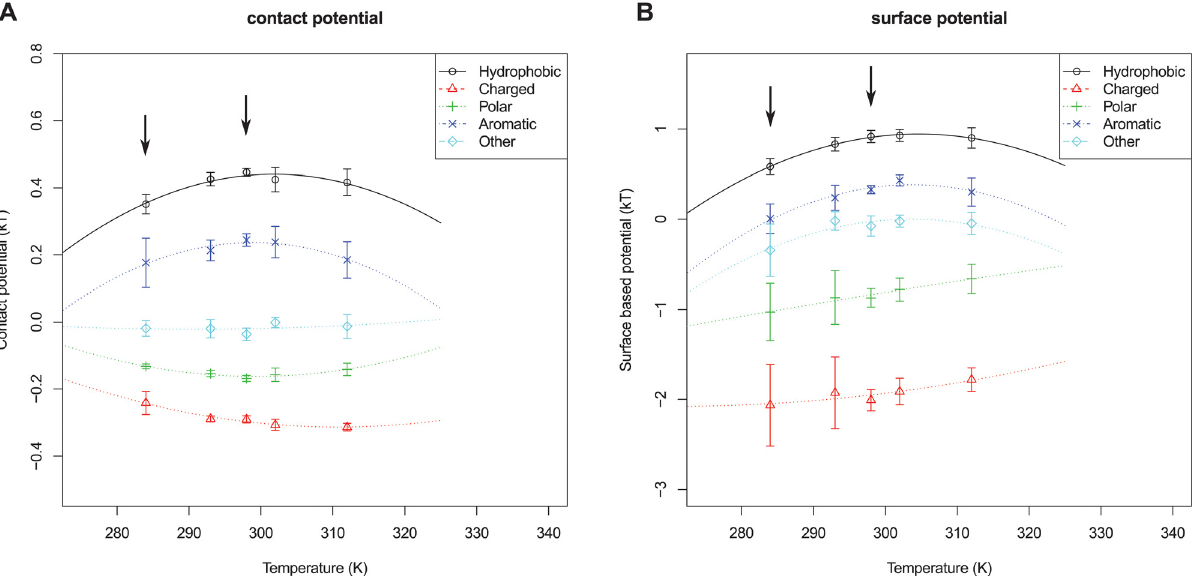
Fig 3. Raw free energies of transfer for classes of amino acids. Contact based (A) and surface based (B) free energies are shown for different classes of amino acids. Points show the free energy estimates for each temperature bin, lines are fitted with a parabola, consistent with the potentials found in [10]. Arrows indicate the bins used to test the significance of the temperature